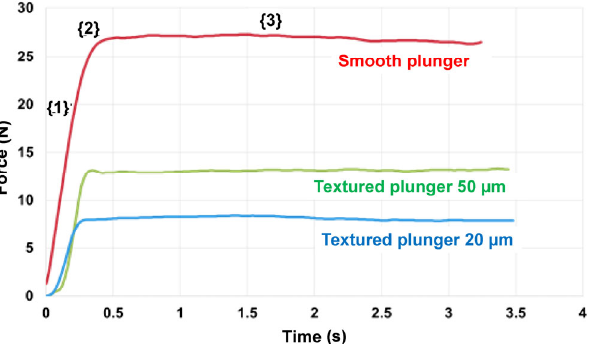
Fig. 5 Typical behavior of friction force resisting the motion of the plunger inside the barrel during a test realized with glycerol under sliding velocity of 2.5 mm/s.